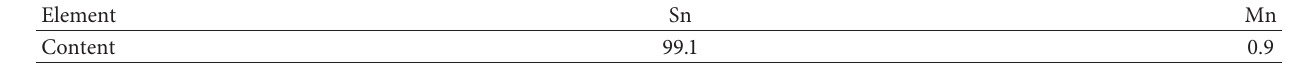
Table 1: Chemical composition of pure tin.